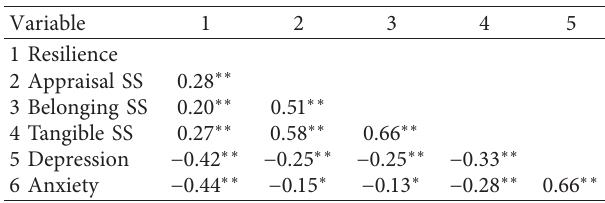
Figure 1: Structural equation model with standardized loadings. Note. BRS1-6 refers to items from the Brief Resilience Scale [33]; appraisal, belonging, and tangible are subscales of the Interpersonal Support Evaluation List-12 [25]; depression was measured by the PHQ-9 [27]; anxiety was measured by the GAD-7 [31]. Table 2: Correlation